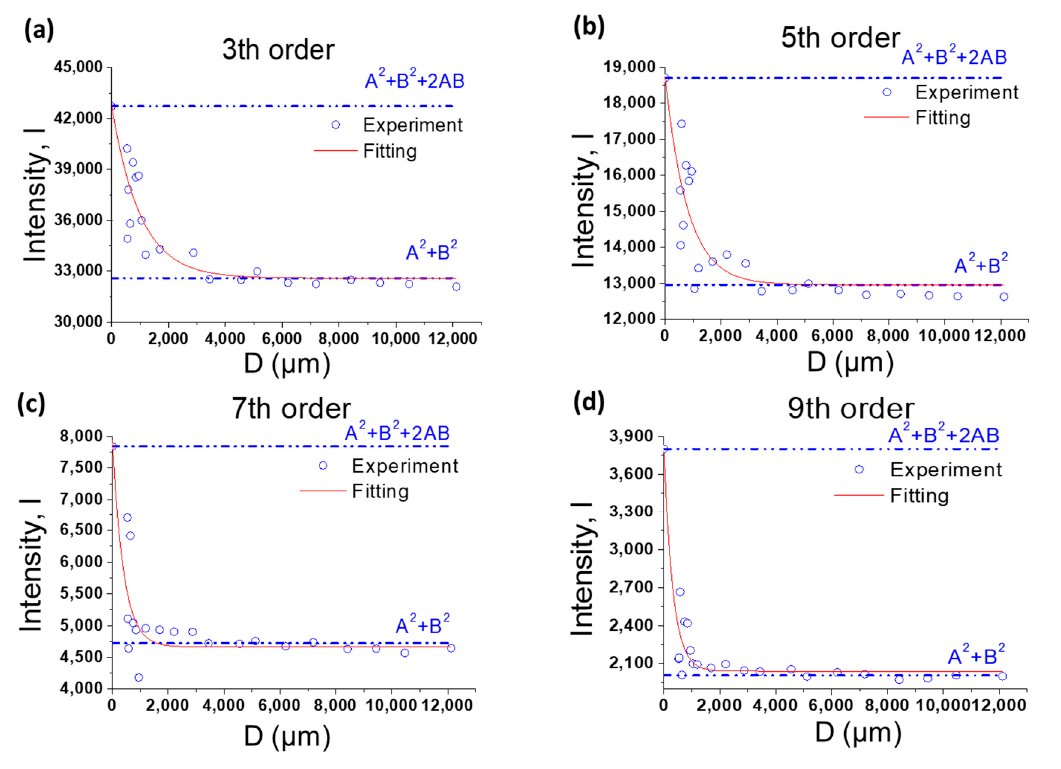
Figure 4. The fitting of the experiment scattering intensities of 3rd ( a ), 5th ( b ), 7th ( c ), and 9th ( d ) peaks. The intensity of 𝐷 = 0 is calculated by the value of A 2 + B 2 + 2 AB . The red dotted line represents an exponential fit of the data following Equation (3) to estimate the effective longitudinal coherence length 𝜉 (cid:4593) .